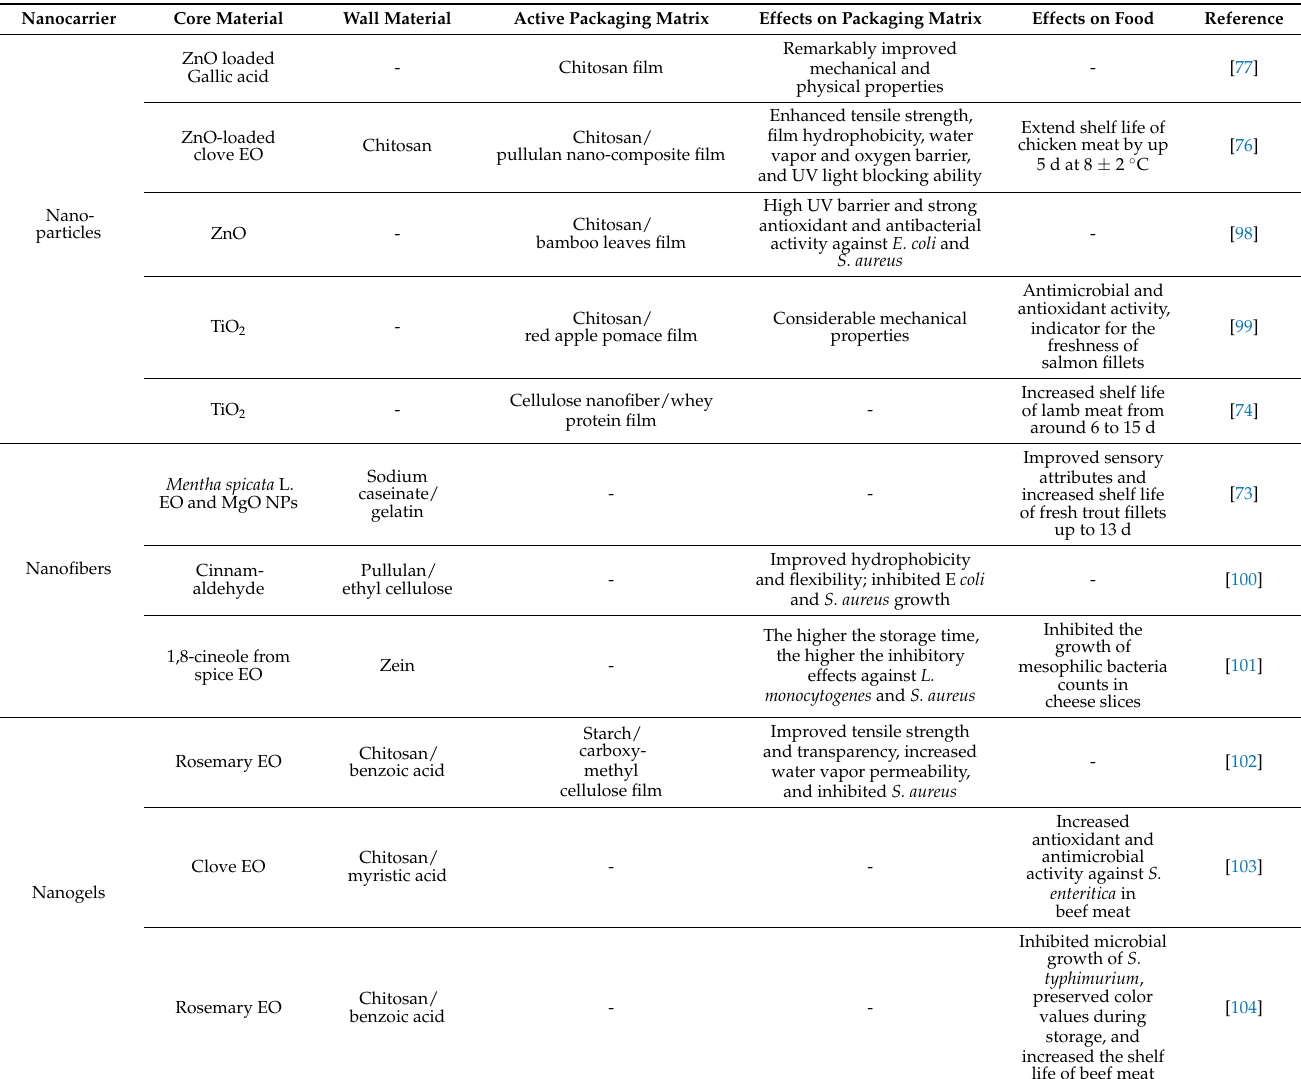
Table 3. Recent examples of improved active packaging by biopolymeric-based nanocarriers and clay-based nanocarriers